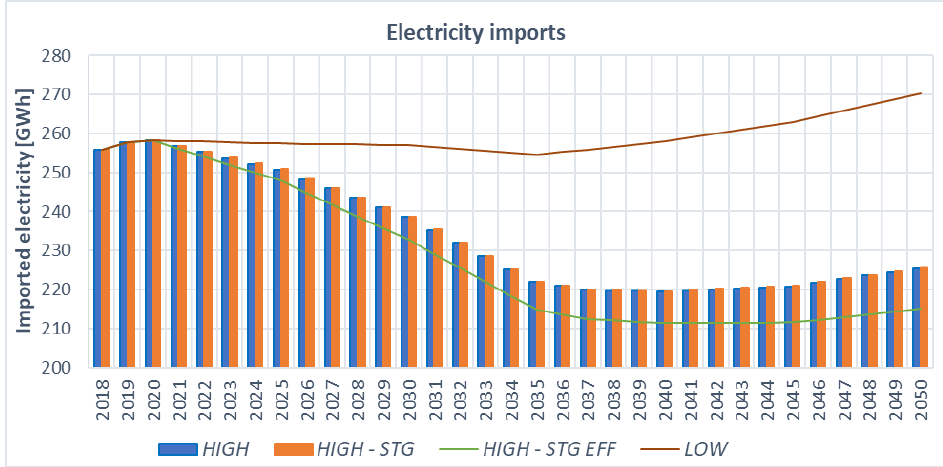
Figure 11. Evolution of electricity imports for the four different scenarios.